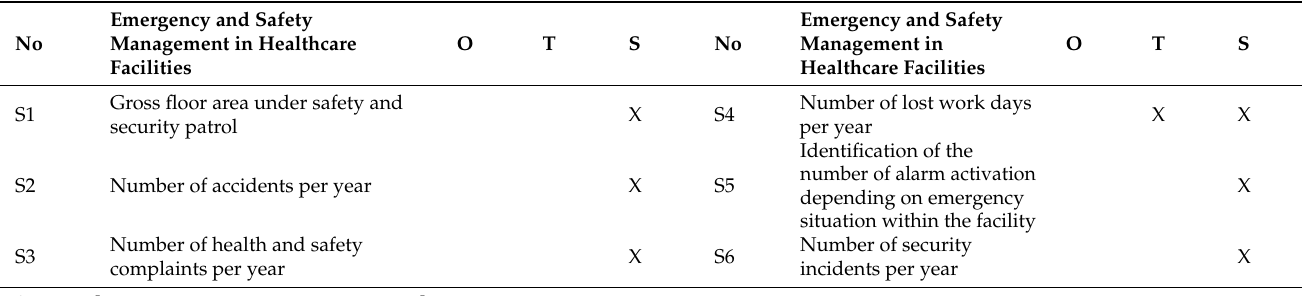
Table 3. FM KPIs for emergency and safety management in healthcare facilities (O: operational, T: tactical, S: strategic).